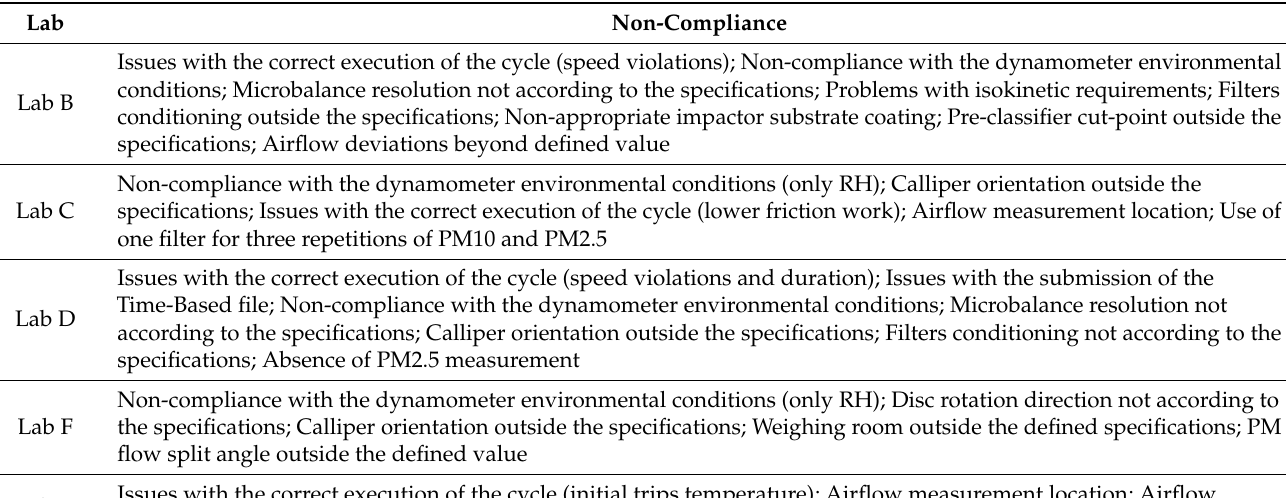
Table 5. Most important deviations from the ILS